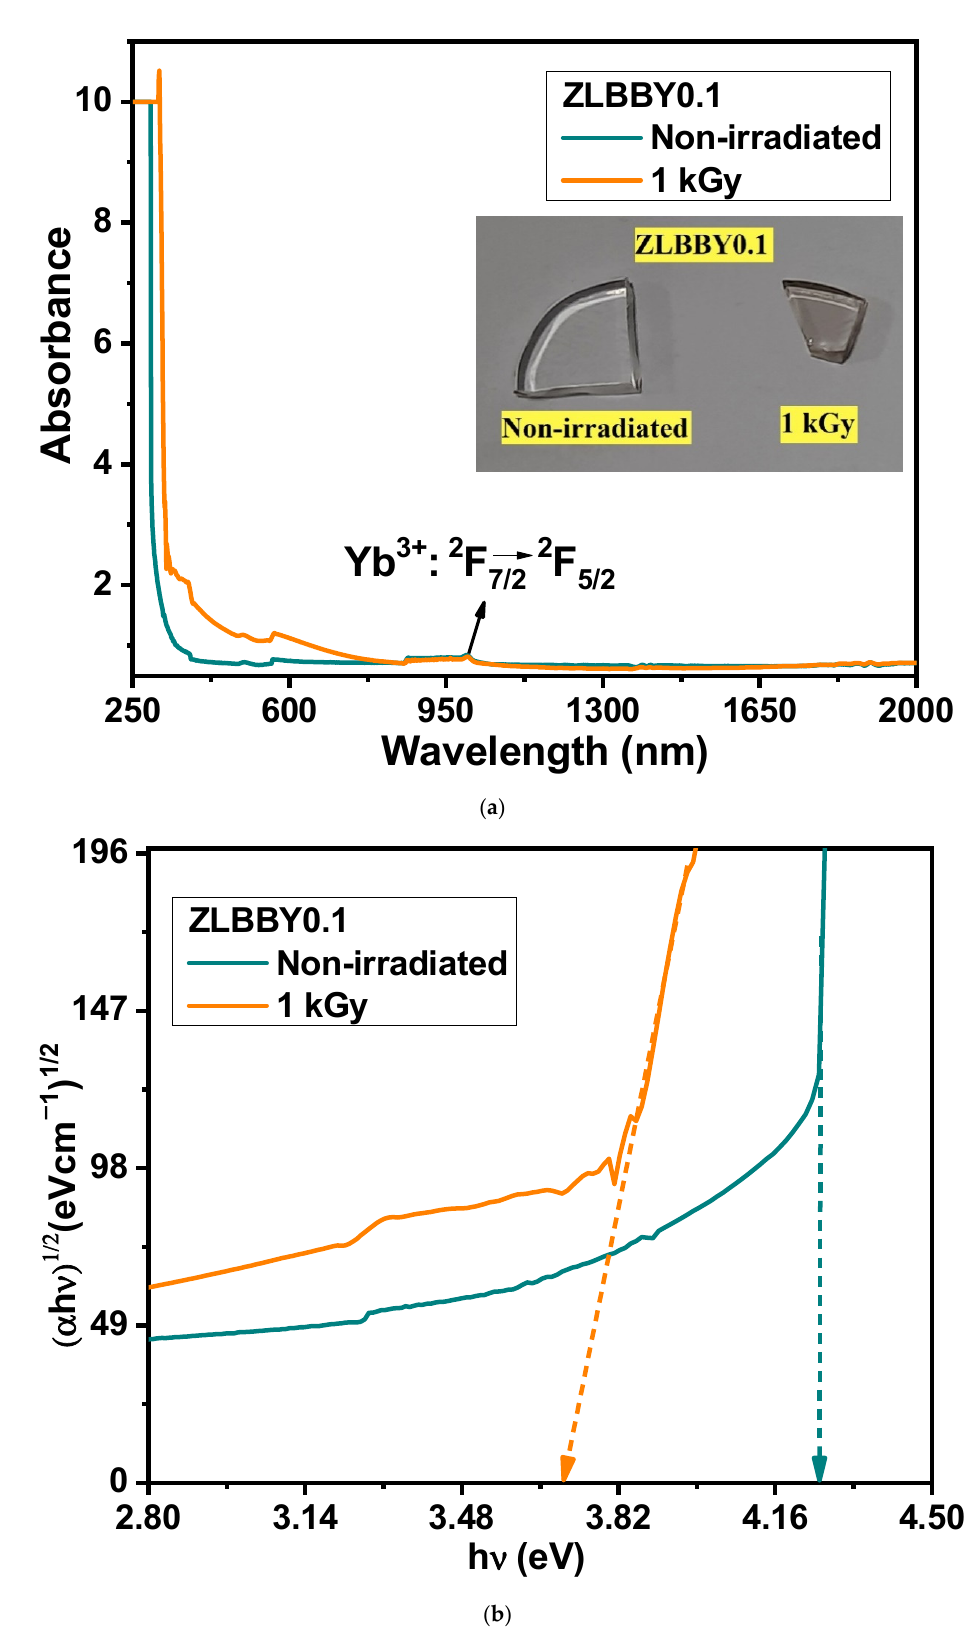
Figure 4. ( a ) Overlaid optical absorption spectra of the non-irradiated and the 1 kGy 𝛾 -irradiated ZLBBY0.1 glasses. The inset contains the photograph of the glasses. ( b ) Tauc’s plots of the non-irradiated and the 1 kGy 𝛾 -irradiated ZLBBY0.1 glasses.